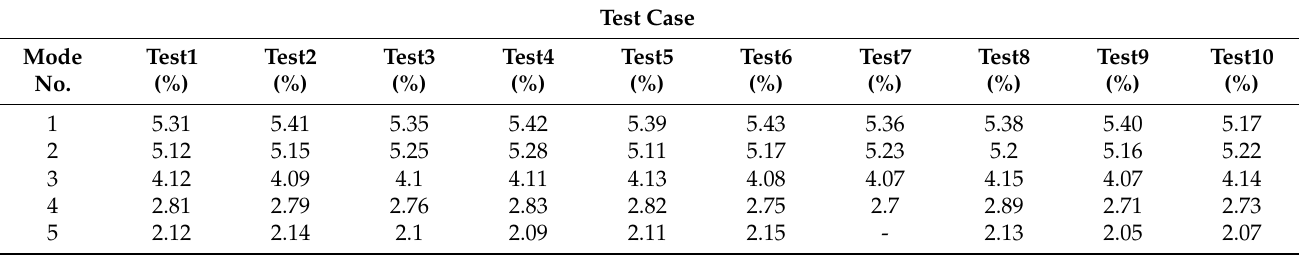
Table 2. Extracted natural frequencies using the EFDD method.